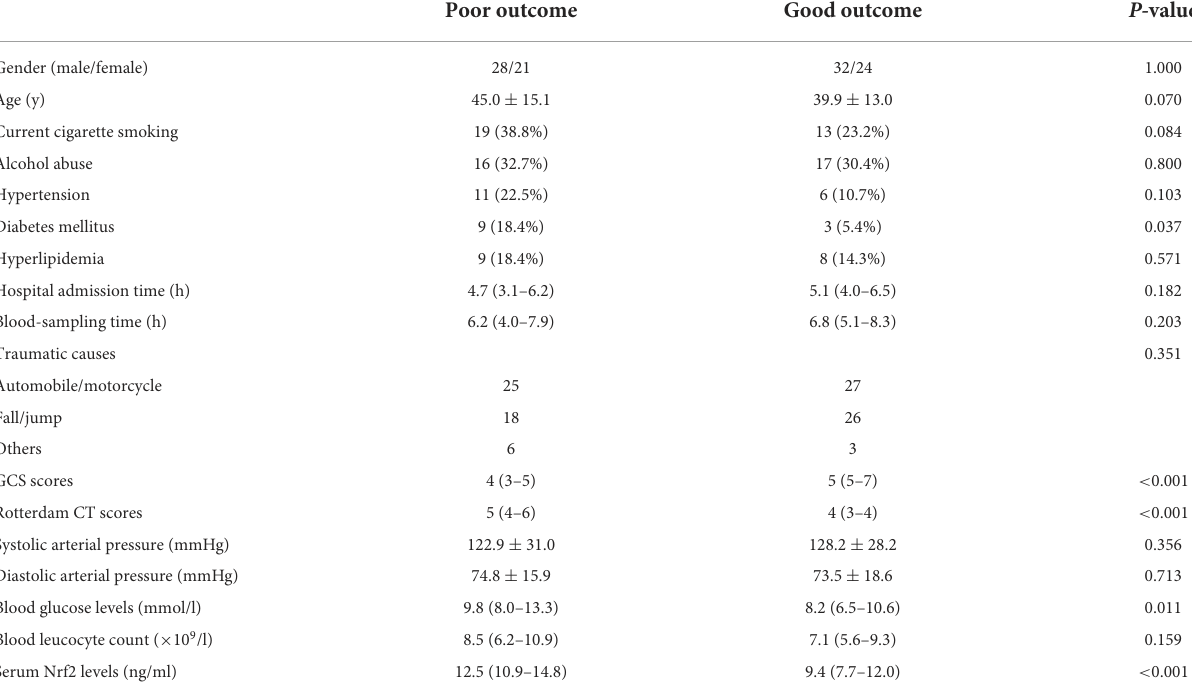
TABLE 4 Factors associated with 180-day poor outcome after severe traumatic brain injury. Poor outcome Good outcome P-